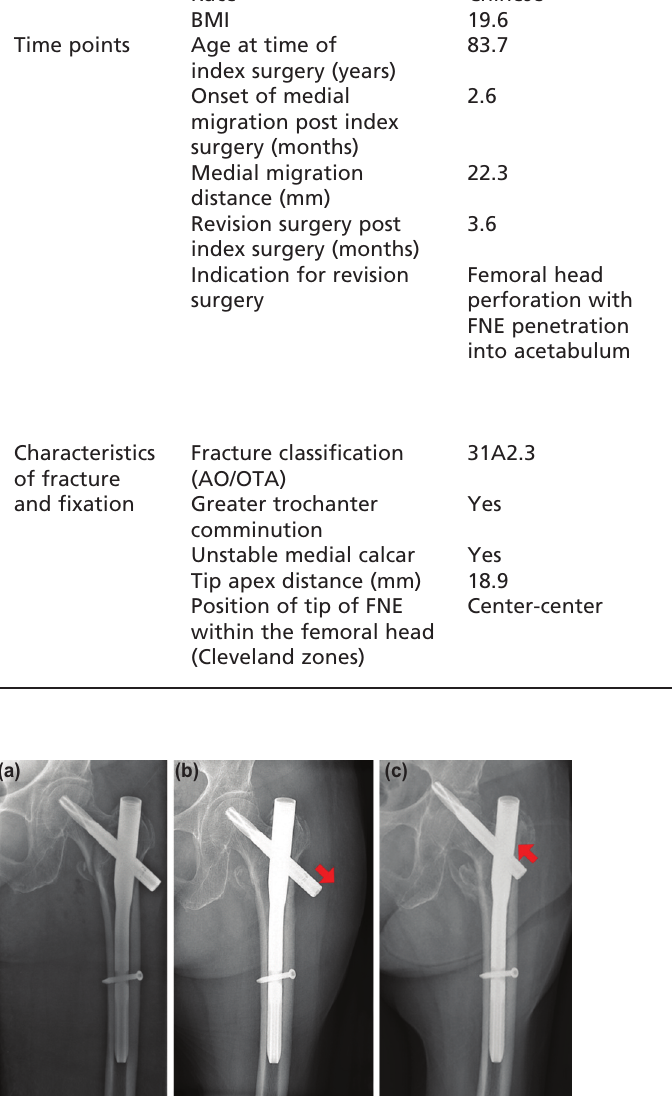
Diagrammatic representation showing repetitive, Fig. 2: linearly arranged, regularly spaced transverse scratch marks (red lines) made on the inferior ridge at the intramedullary nail–FNE interface as the FNE migrates medially.